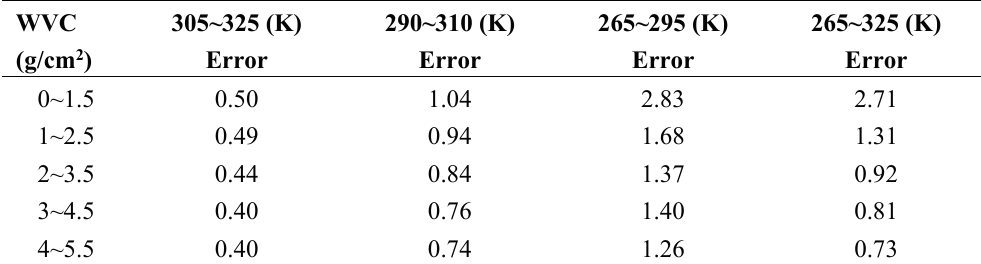
Table 2. Effect of the emissivity uncertainty ( Δ ε = 0.01) on LST